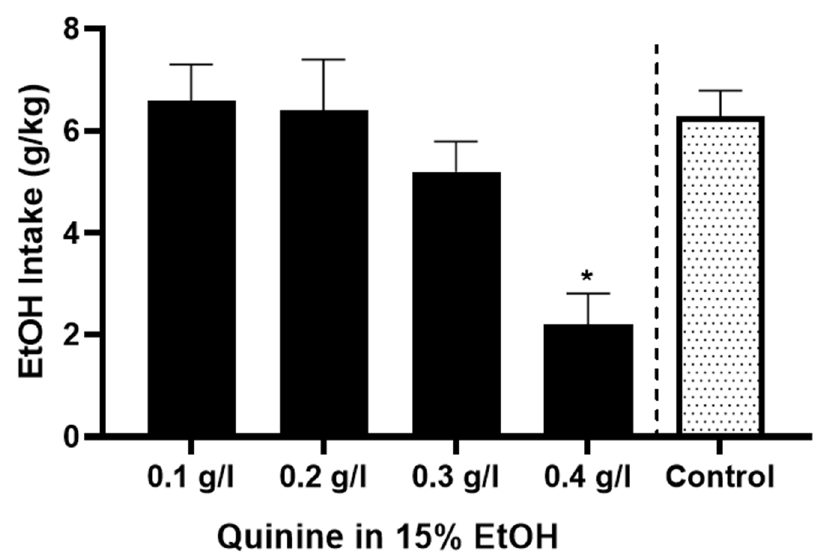
Figure 1. In alcohol naïve female P-rats ( n = 6), using a daily escalation paradigm of increasing quinine concentration in 15% EtOH, 0.4 g/L quinine significantly reduced 24 h intake of 15% EtOH compared to intake of 0.1, 0.2, or 0.3 g/L quinine (* p < 0.01; p < 0.05 and p < 0.05, respectively, Tukey’s posthoc test). For comparison, the mean 4-day intake of EtOH in a separate set of control female P-rats drinking 15% quinine without EtOH is presented ( n = 5).